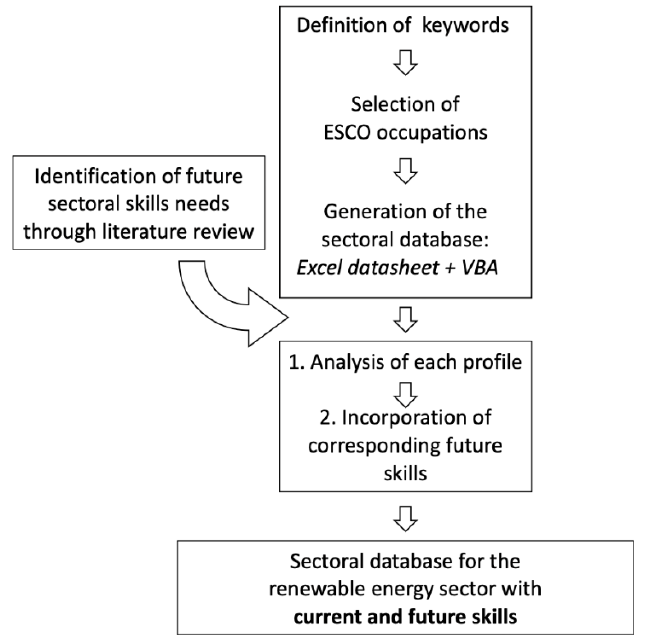
Figure 1. Summary of the methodology.